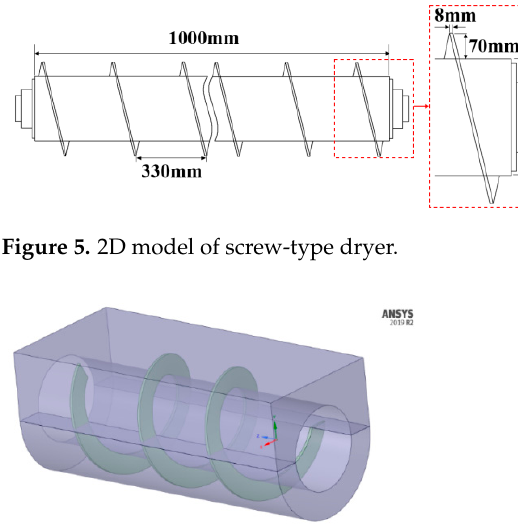
Figure 6. 1/6 partial model of screw-type dryer.